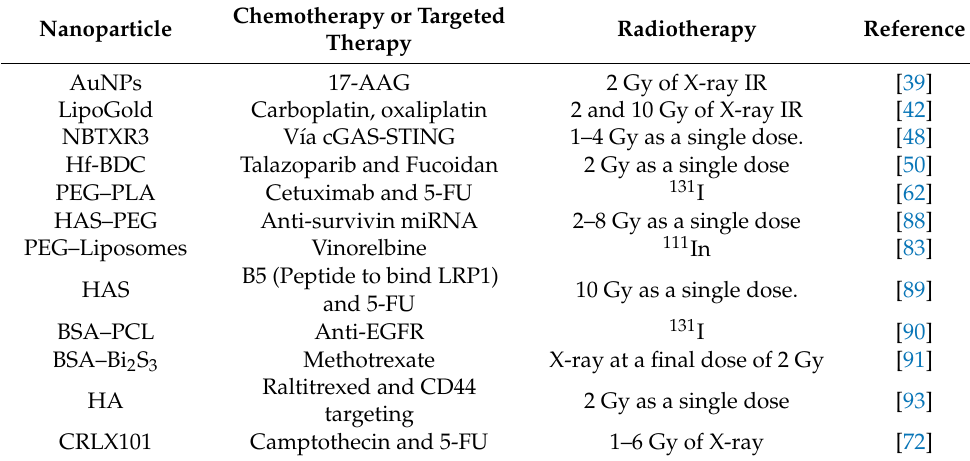
Table 2. Nanoparticles carriers of chemotherapeutic agents for colorectal